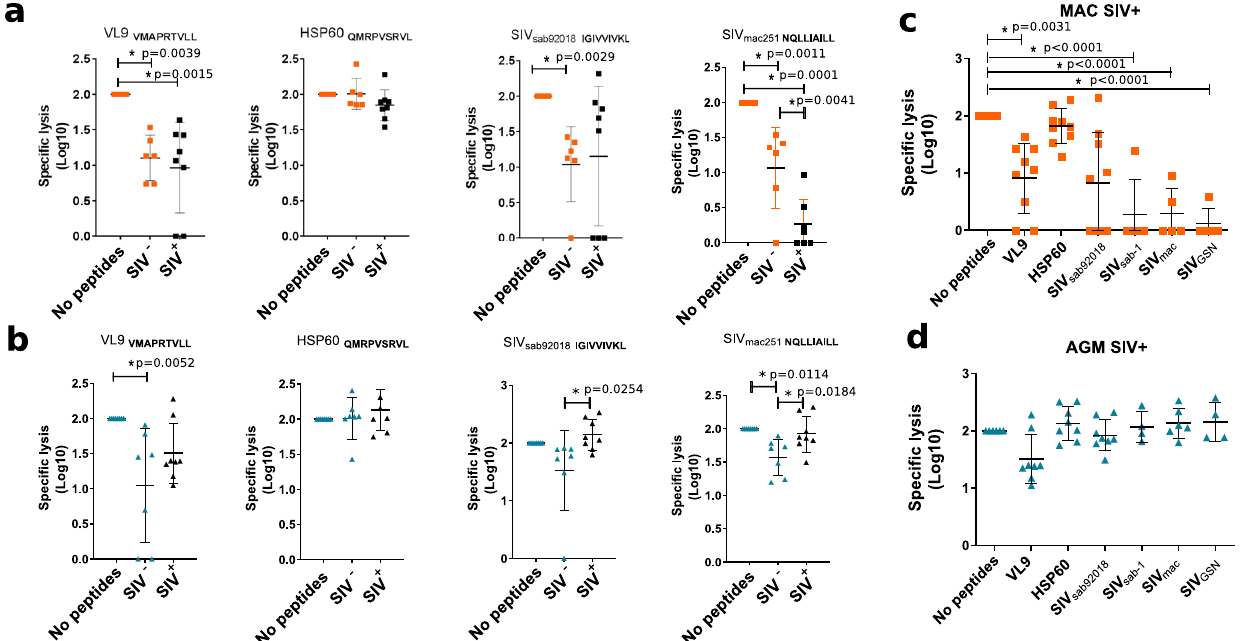
Fig. 8 Differences in MHC-E restricted activity of secondary lymphoid tissue NK cells between natural and heterologous hosts. a , b HLA-E dependent cytotoxic activity of NK cells isolated before infection and in chronic infection from LN of MAC (orange), and AGM (blue). K562-E*0101 were loaded or not with peptides. Uninfected MAC are indicated in orange squares and uninfected AGM in blue triangles. SIV-infected animals are indicated in black. The black line indicates the median and error bars the interquartile range. Each symbols represents a unique monkey. For Groups comparisons two-sided Wilcoxon signed-rank test with Bonferroni correction were used ( n = 3). P values of less or equal to 0.05 were considered statistically signi fi cant. Asterix indicate signi fi cant change when compared to the base line. Exact P value are provided on the graphs. c , d HLA-E dependent cytotoxic activity of NK cells isolated from spleen of chronically infected c MAC and d AGM against distinct SIV ENV peptides. The black line indicates the median and error bars the interquartile range. Each symbols represents a unique monkey. For Groups comparisons two-sided Wilcoxon signed-rank test with Bonferroni correction were used ( n = 7). P values of less or equal to 0.05 were considered statistically signi fi cant. Asterix indicate signi fi cant change when compared to the base line. Exact P values are provided on the